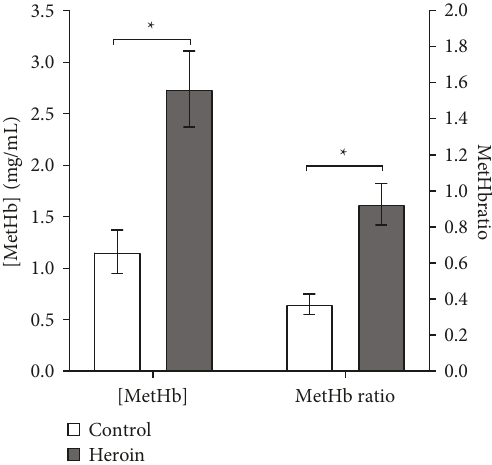
Figure 1: Comparative analysis of serum (a) methemoglobin concentration ([Met-Hb]) and (b) methemoglobin ratio to total hemoglobin between chronic heroin-addicted subjects and control subjects. Results are presented as mean ± SEM in milligram per milliliter (mg/mL). ∗ indicates a significant comparative analysis with p < 0 .